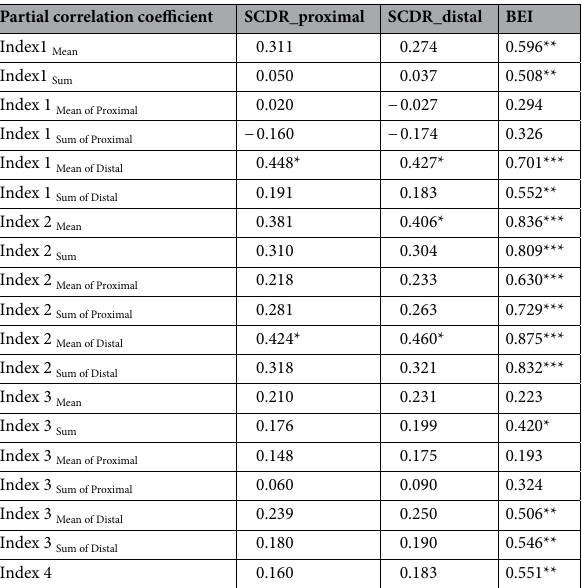
Table 3. Comparison of the four indices with the clinical gold standard measurements. SCDR standardized circumference difference ratio, BEI bioelectrical impedance *0.01 < p < 0.05, **0.001 < p < 0.01, *** p < 0.001.